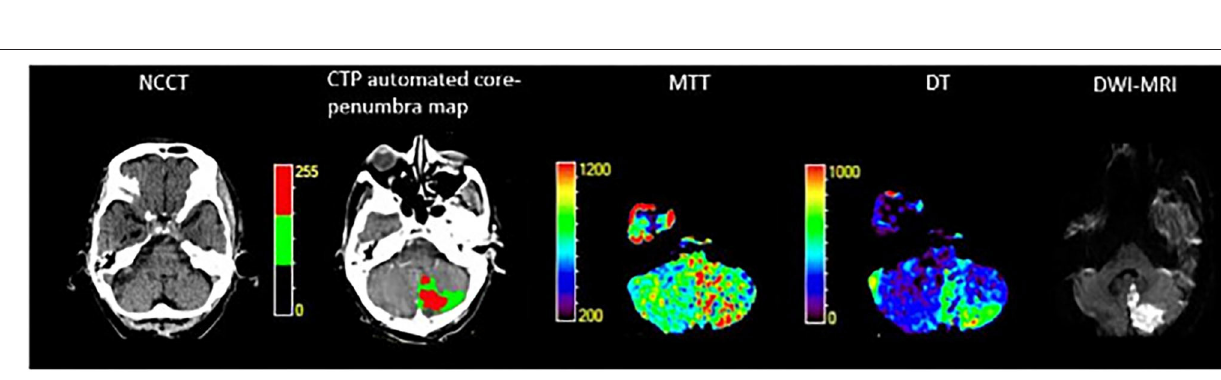
FIGURE 3 | 74-year-old male who presented with vertigo, left dysmetria and left sided weakness. NCCT, Non contrast computed tomography; CTP, Computed tomography perfusion; MTT, Mean transit time; DT, Delay time; DWI-MRI, Diffusion weighted imaging—magnetic resonance imaging.